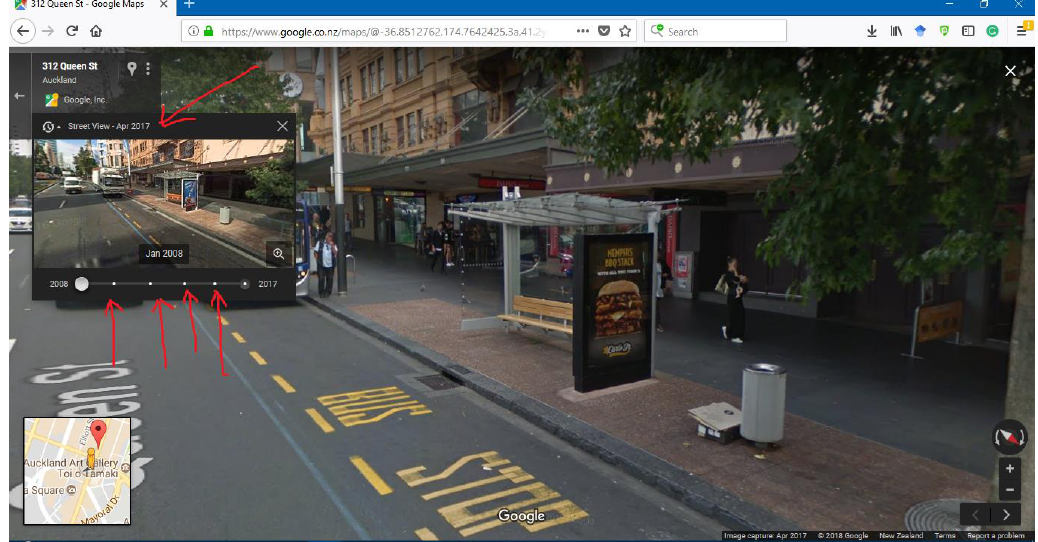
Figure A1. Image Capture Date Example